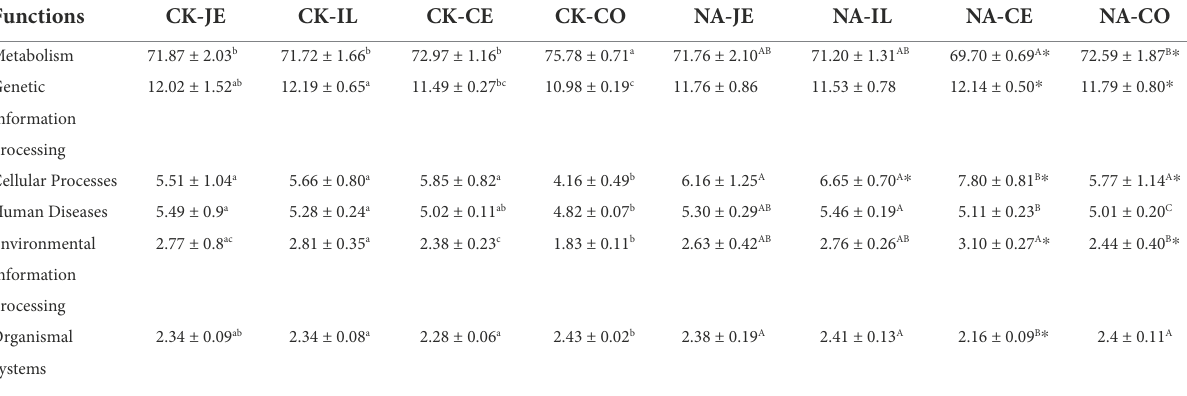
TABLE 1 Relative abundance of primary functional genes in gut microbiota of normal and NAFLD mice.